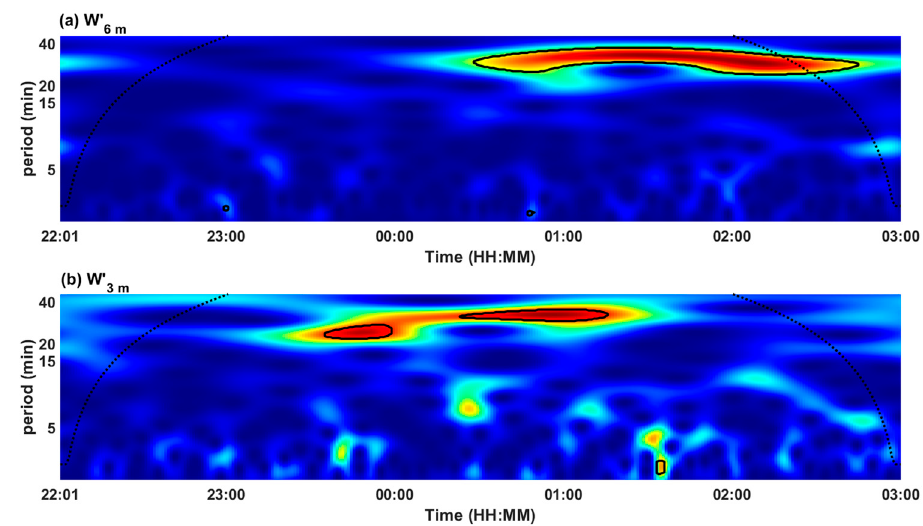
Figure 9. The local wavelet power spectrum using the Morlet wavelet for w’ averaged every 1 min for 2200 08 Oct. 2017 - 0300 09 Oct. 2017 in Case 4: ( a ) w’ at 6 m height, ( b ) w’ at 3 m height. The power is normalized by 1 / σ 2 . The thick contour encloses regions greater than the 0.1% significance level for a red-noise process. The dotted line is the cone of influence.